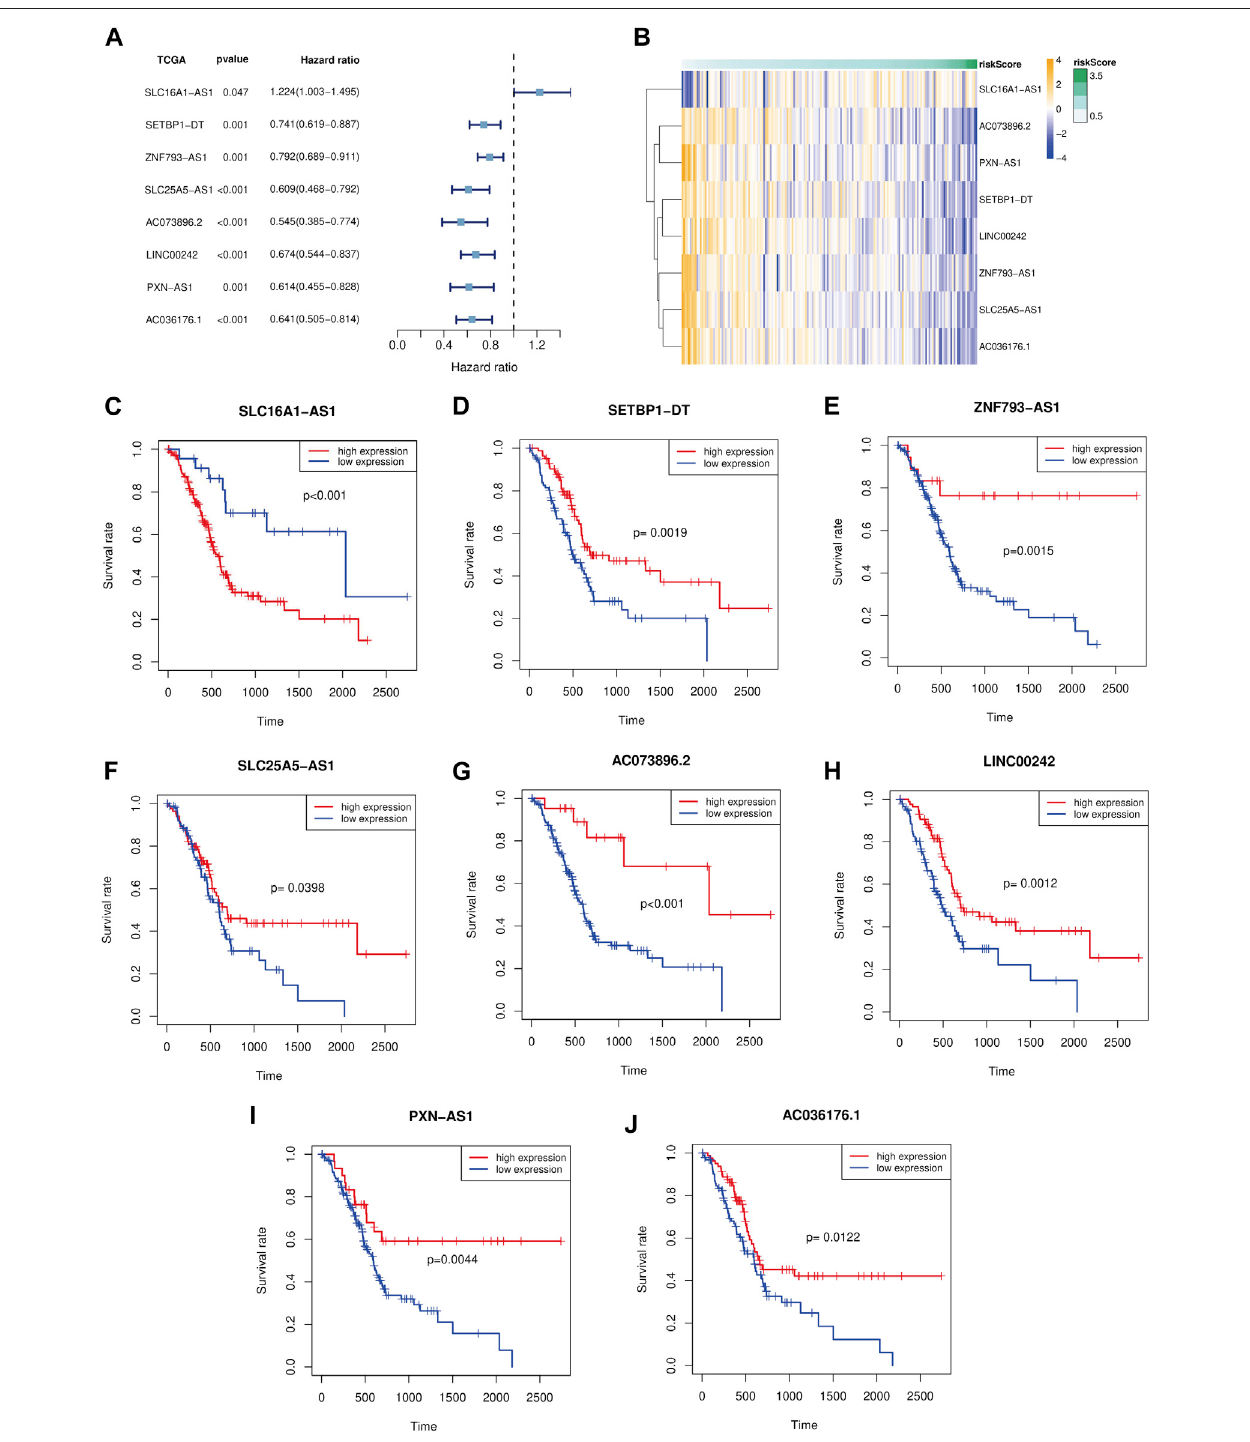
FIGURE4| ForestplotoftheunivariateCoxanalysisineightFe-LPM (A) .HeatmapshowedtherelationshipbetweenriskscoreandexpressionoftheeightFe-LPM (B) . Kaplan-Meier analysis in different expression subgroups of the eight Fe-LPM (C – J) .